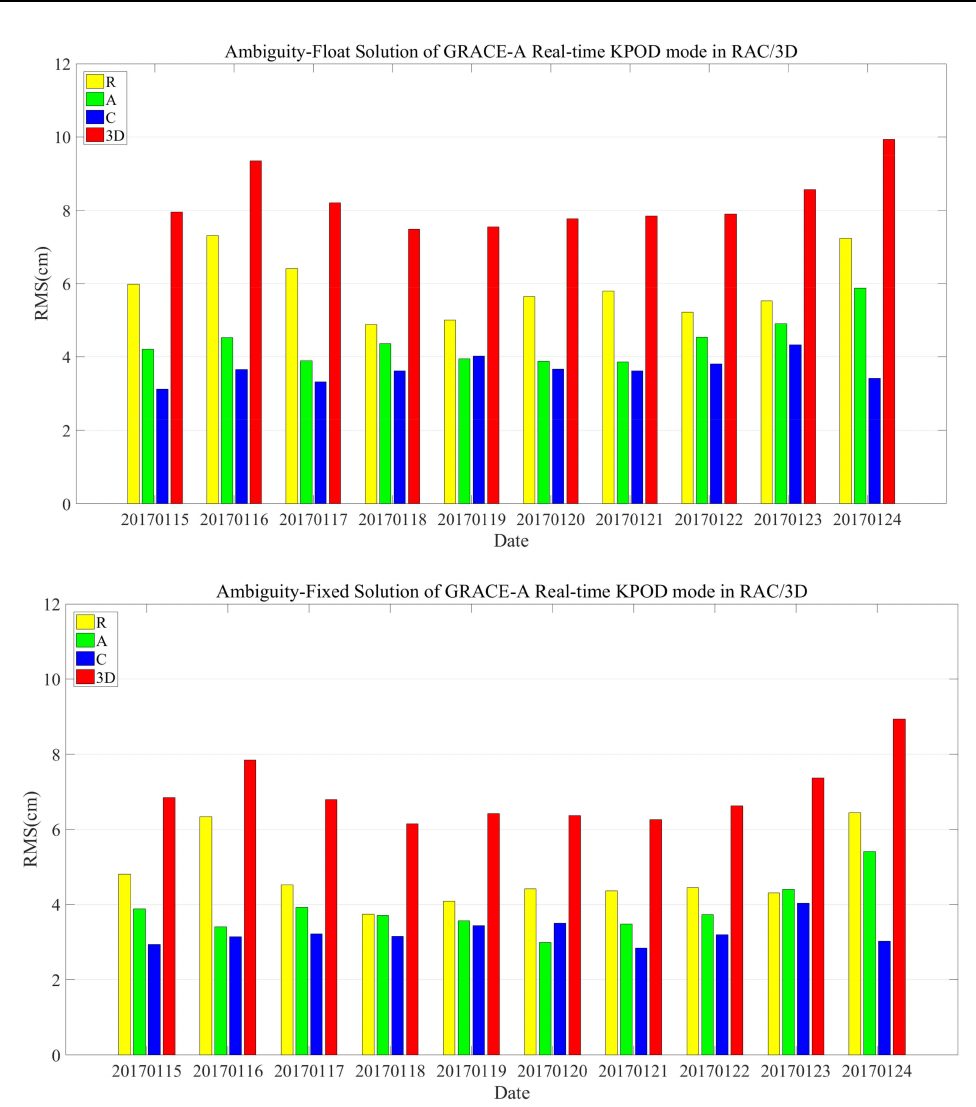
Figure 7. The accuracy (RMS) of real-time KPOD ambiguity-float ( upper ) and ambiguity-fixed ( bottom ) solution for